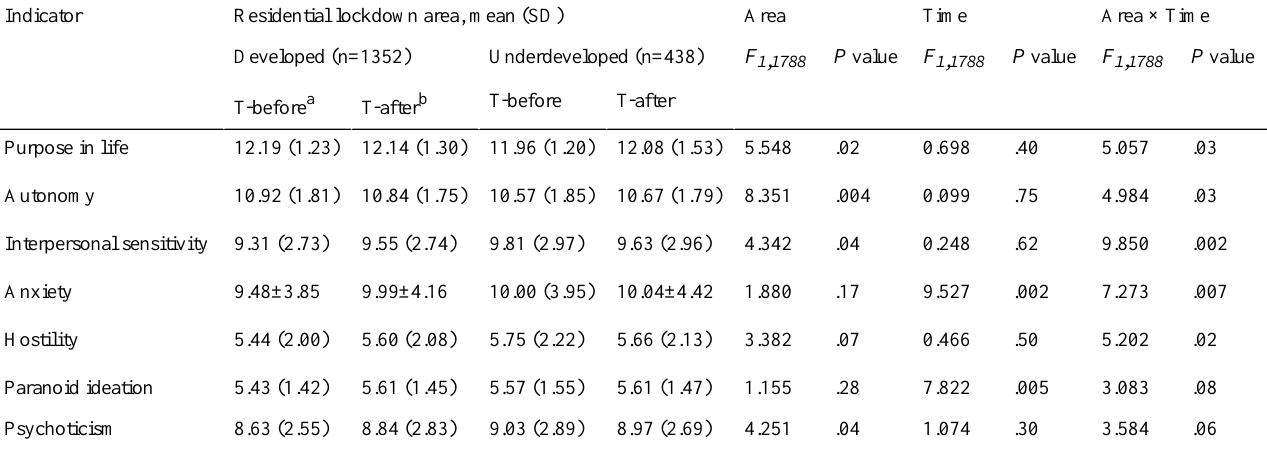
Table 6. Repeated measures analysis of variance on subjective well-being in the residential lockdown